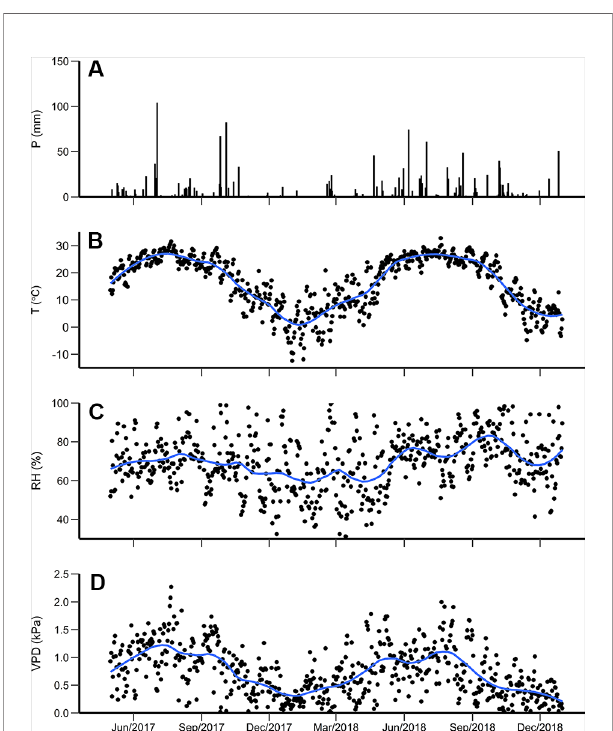
FIGURE 1 | (A) Daily precipitation (P), (B) average temperature (T), (C) relative humidity (RH), and (D) vapor pressure de fi cit (VPD) from April 2017 to September 2018. The blue line is the locally weighted regression using local neighborhood with size of 5 days.